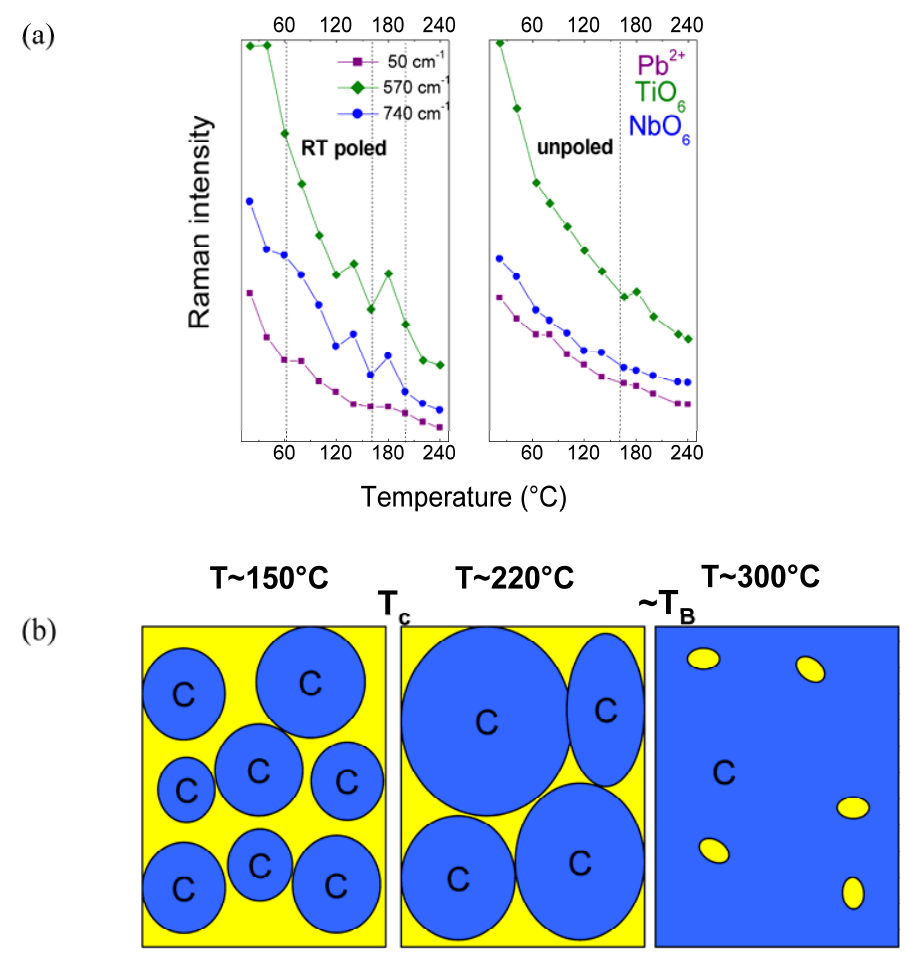
Figure 7. ( a ) Temperature dependences of Raman mode intensities for RT poled and unpoled textured ceramic [62]. The dashed lines represent the phase transition temperature determined from the dielectric and thermal expansion measurements; ( b ) Sketch of continuous evolution of symmetry towards the “true cubic one”(C), i.e ., cubic without polar nanoregions. T and T denote the temperatures of ferro/paraelectric Curie phase transition C B and the Burns (vanishing of PNR on heating, nucleation on cooling),